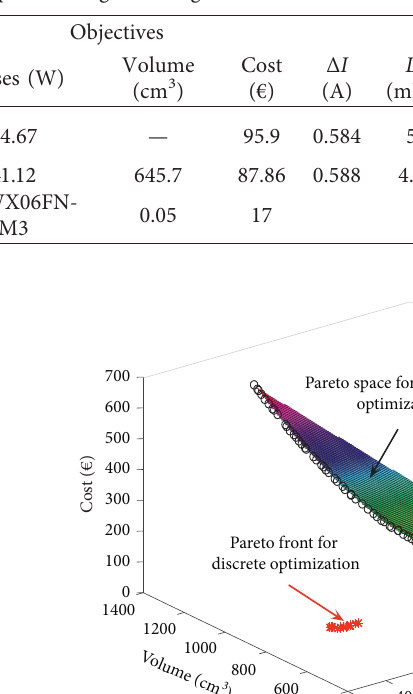
Figure 8: Pareto front of the (a) biobjective optimization problem cost vs. losses. (b) Triobjective optimization problem cost vs. volume vs. losses. Table 6: Optimal design of the grid-connected inverter for the multiobjective optimization problems.